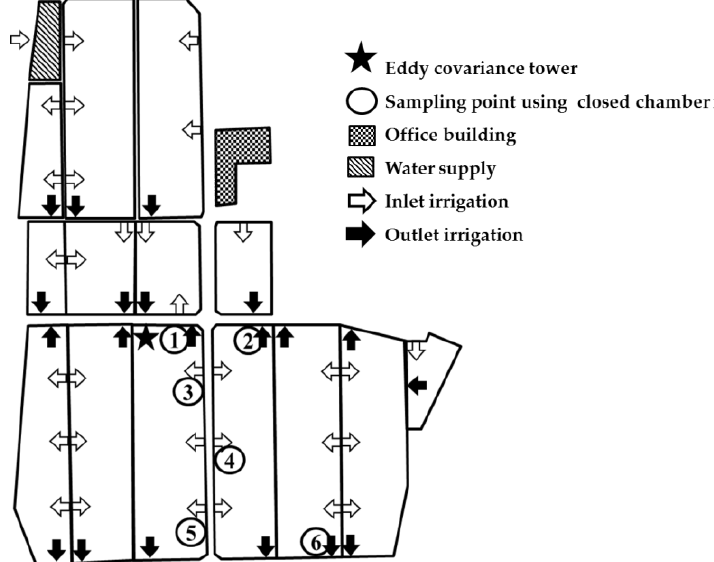
Figure 1. Monthly average air temperatures ( ◦ C) and total amounts of rain (mm) at the experimental field in 2014.